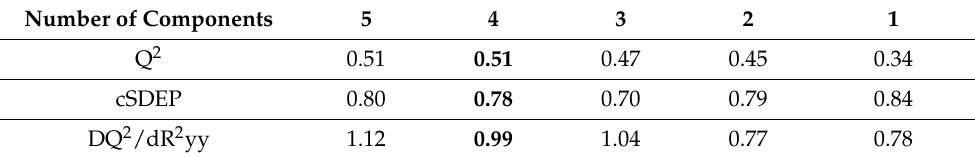
Figure 2. The experimental versus predicted pIC 50 values for the CoMFA training set and test set. Table 3. Progressive scrambling test results obtained for the comparative molecular fields analysis (CoMFA)